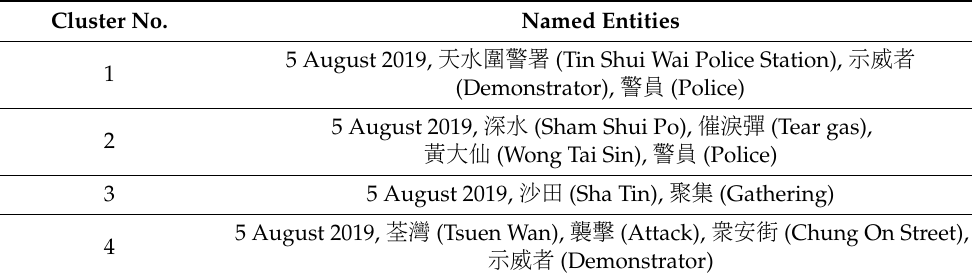
Table 4. Some entities with relatively high frequency in each cluster. Cluster No.